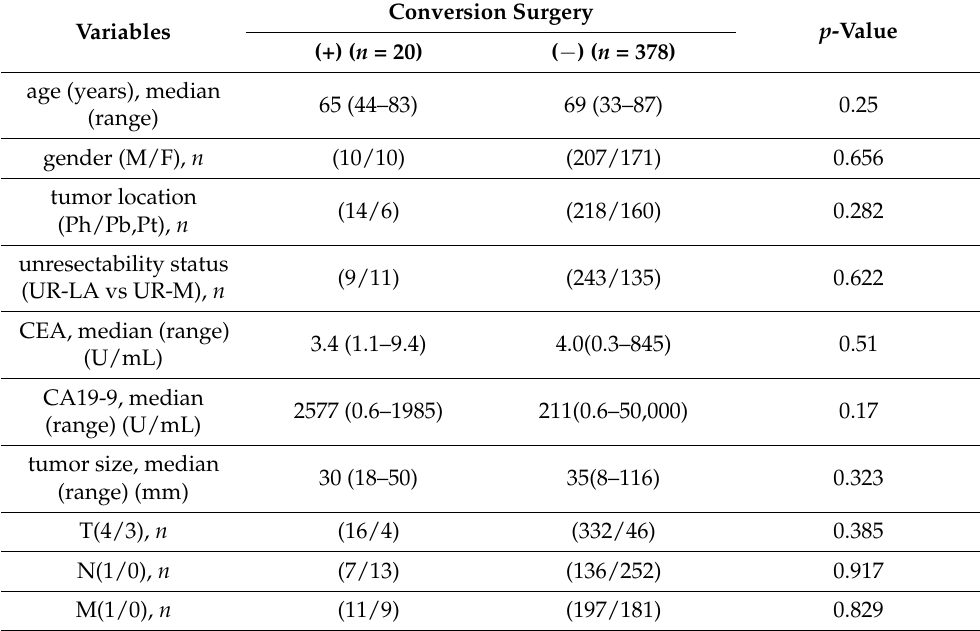
Table 1. A comparison of the clinical characteristics between CS and non-CS patients. Conversion Variables